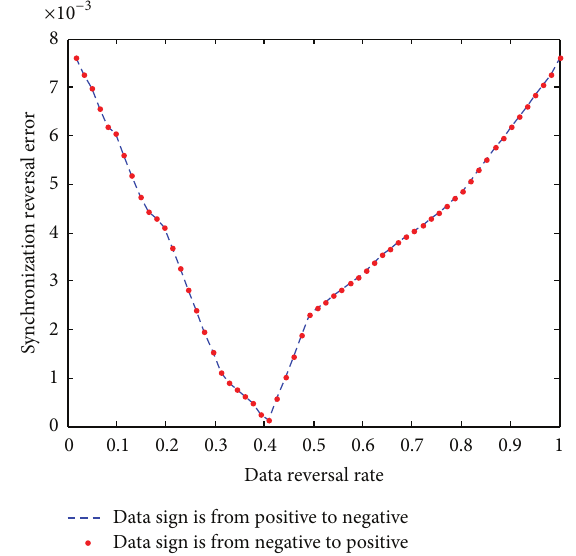
Figure 3: The estimated reversal error change with changing data reversal